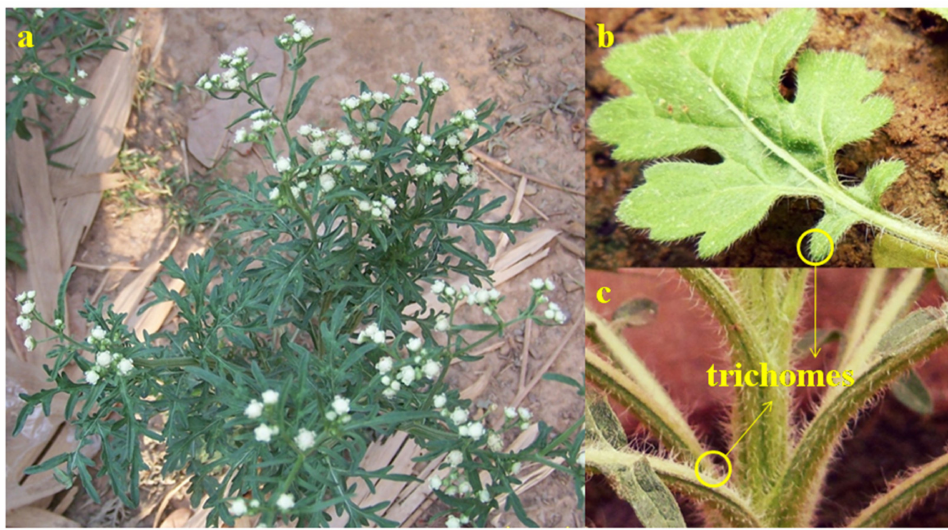
Figure 3. ( a ) Parthenium hysterophorus and the capitate-sessile trichomes present on its ( b ) leaves and ( c )